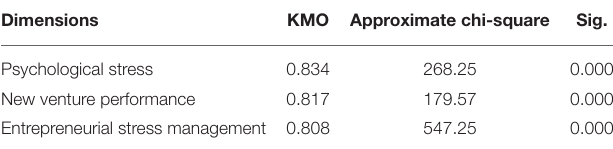
TABLE 5 | Validity analysis results of the QS.